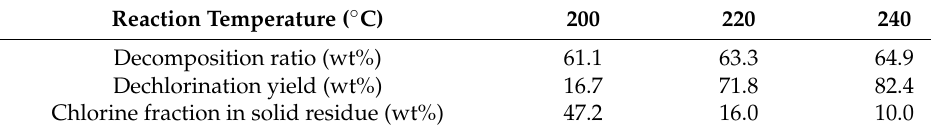
Table 1. Decomposition ratio and dechlorination yield of PVC-P.